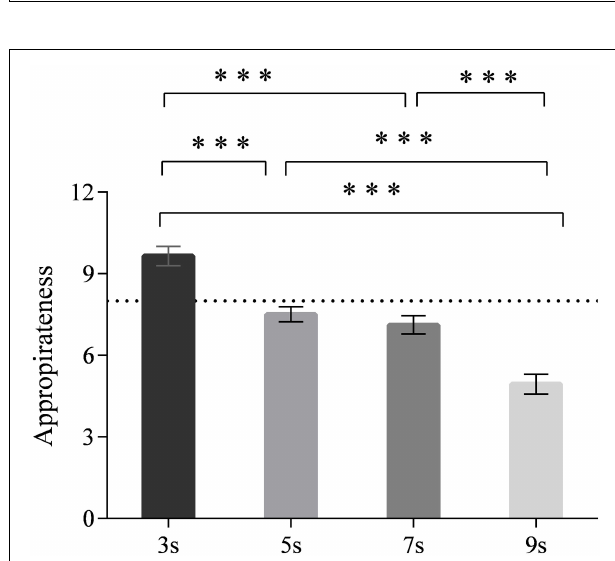
FIGURE 9 | Appropriateness ratings for different time intervals. (Notes. *** p < 0.001).